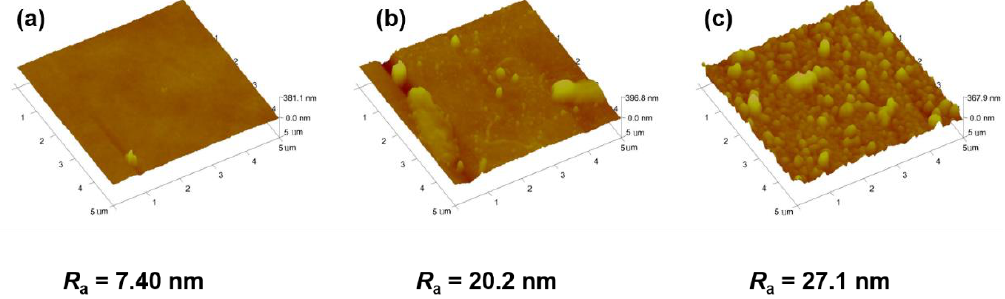
Figure 5. AFM images of PSf-1BLmembranes prepared from di ff erent pH values of LS aqueous solution. ( a ) pH = 8; ( b ) pH = 7; ( c ) pH = 5.